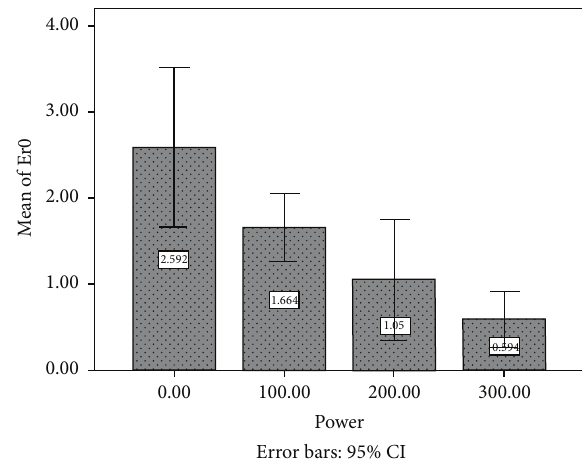
Figure 3: This diagram shows the changes in frictional force (N) between the wire and bracket at 0 ∘ of angulation with an increase in laser power (mj/s). Frictional resistance decreased with an increase in Er:YAG laser power ( 𝑃 = 0.000 ).